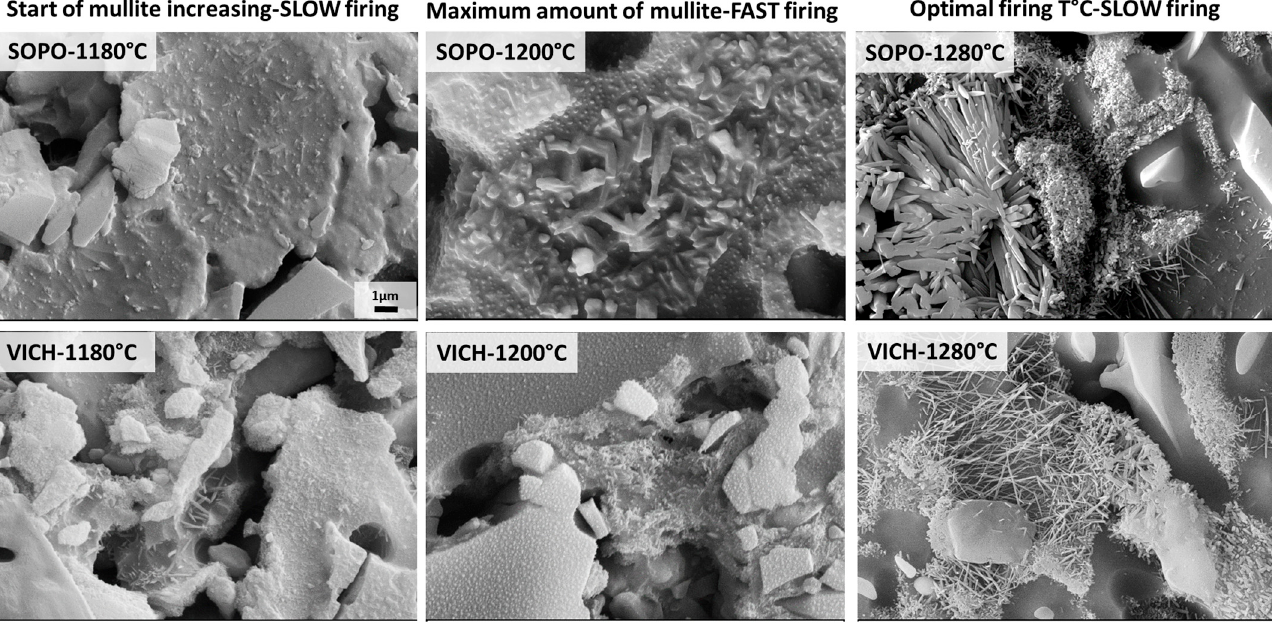
Figure 9. Mullite morphology of porcelains by SEM micrographs after HF etching (scale bar = 1 µm).